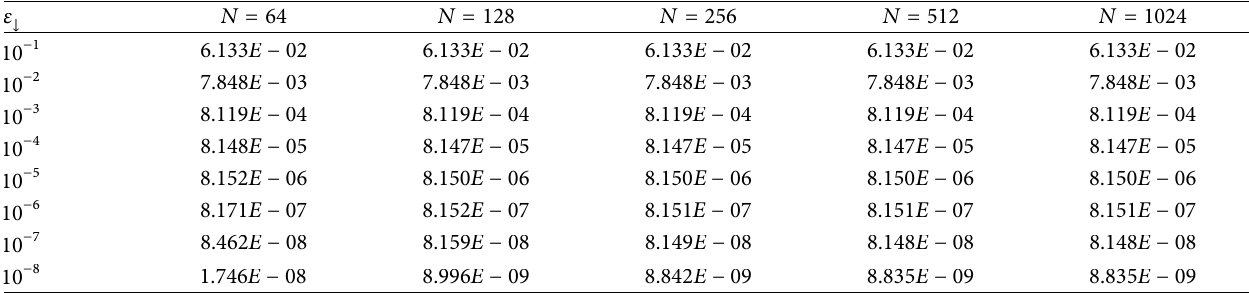
푁 , for the solution 휀,2 𝐸